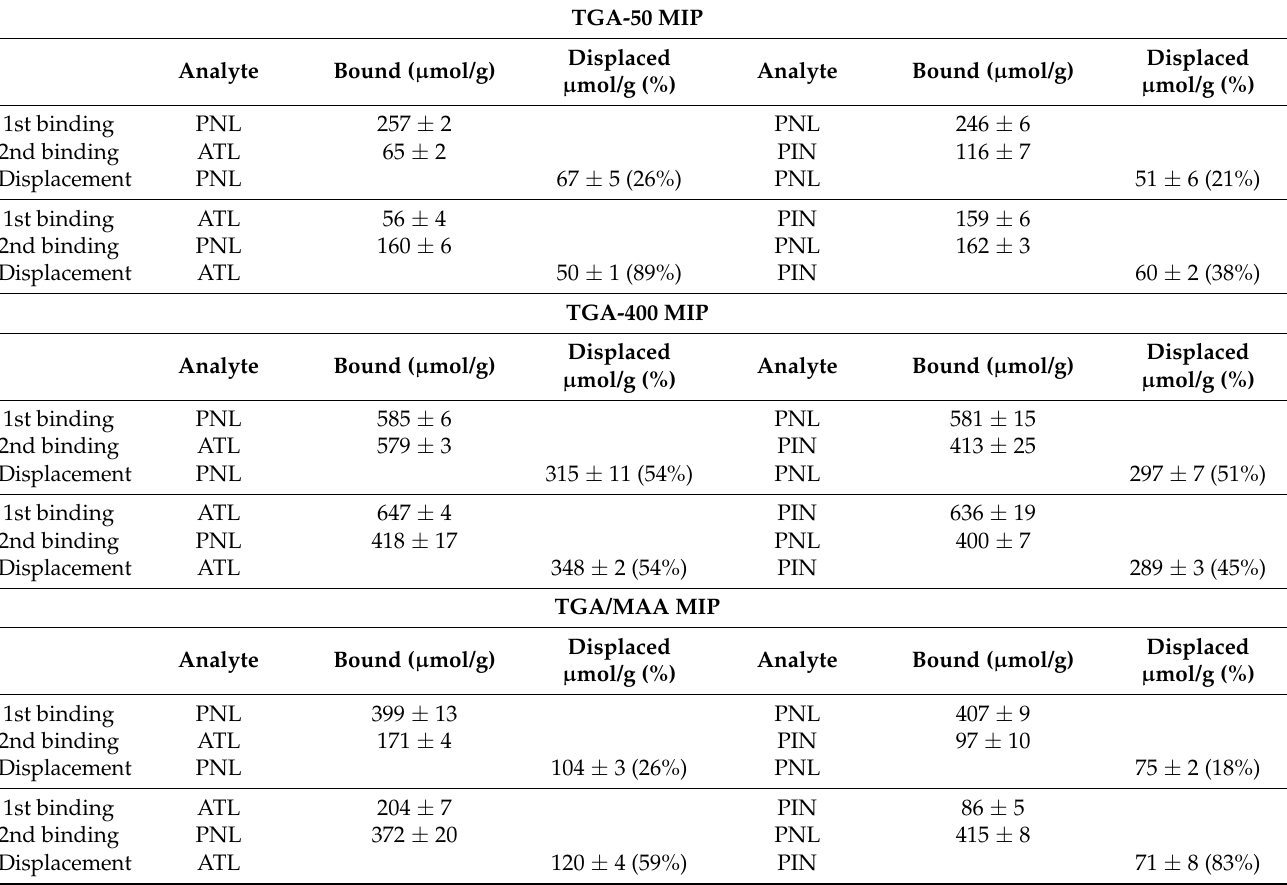
Table 3. Displacement binding tests between template PNL and analogues ATL and PIN to the TGA-50,TGA-400 and TGA/MAA